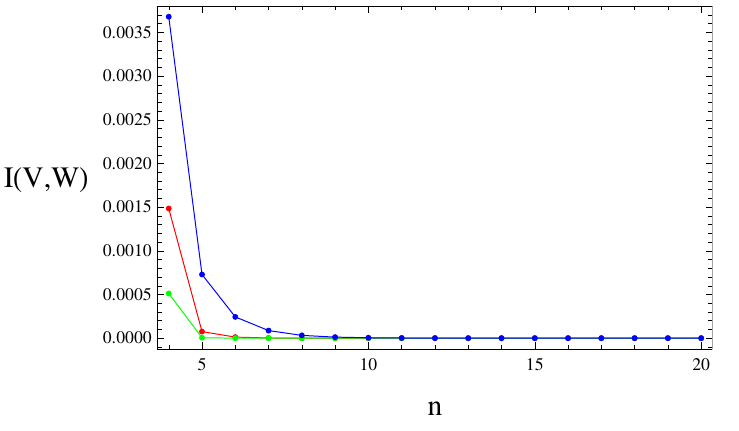
Figure 22 . The mutual information of gauge (cid:12)elds coupling with matter between two squares of equal sizes separated by a distance equal to the square size for algebra B with m = 1 line), m = 1 (red line) and m = 2 (green line).